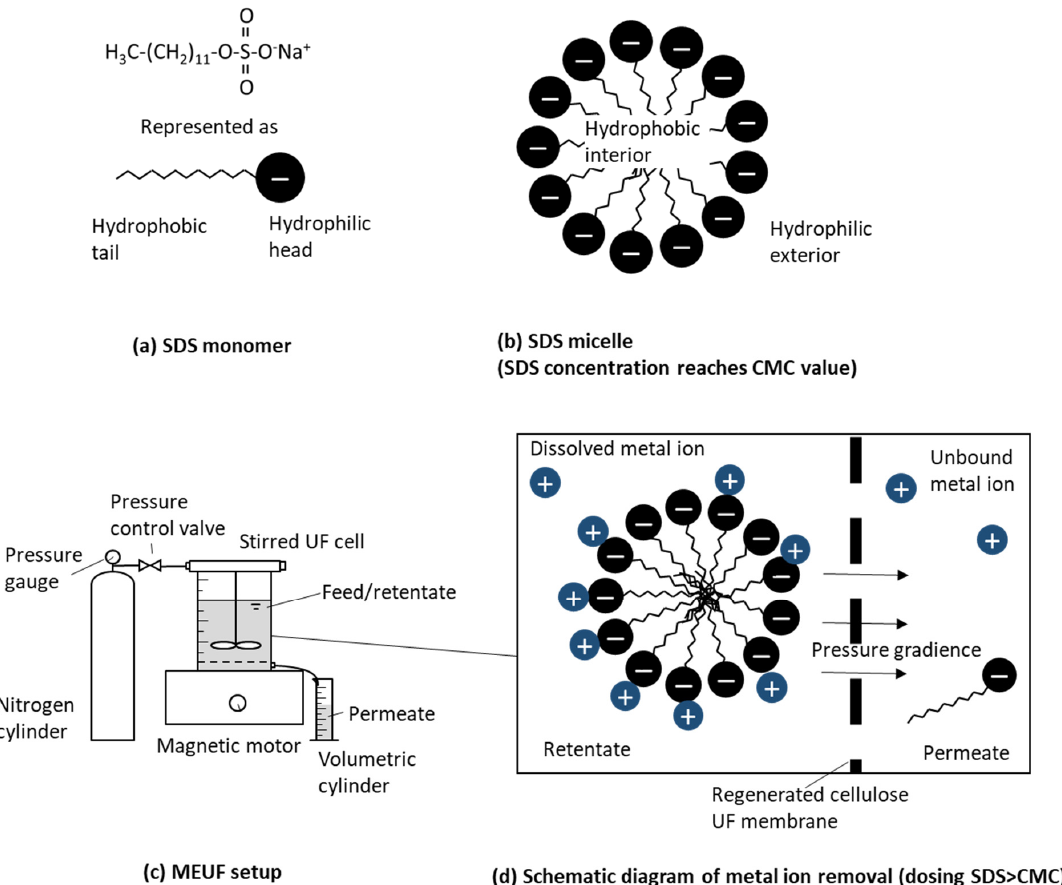
Figure 1. A Schematic diagram of ( a ) SDS monomer, ( b ) SDS micelle (when SDS concentration > CMC) ( c ) micellar-enhance ultrafiltration (MEUF) setup, and ( d ) mechanism of MEUF removal of metal ions.